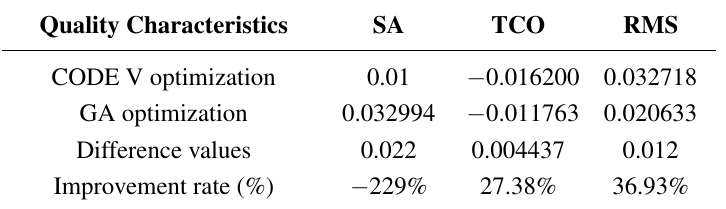
Table 12. Comparisons of third-order aberrations of the built-in and proposed optimization methods for 550 degrees myopia and 175 degrees astigmatism for pupil size 5 mm.